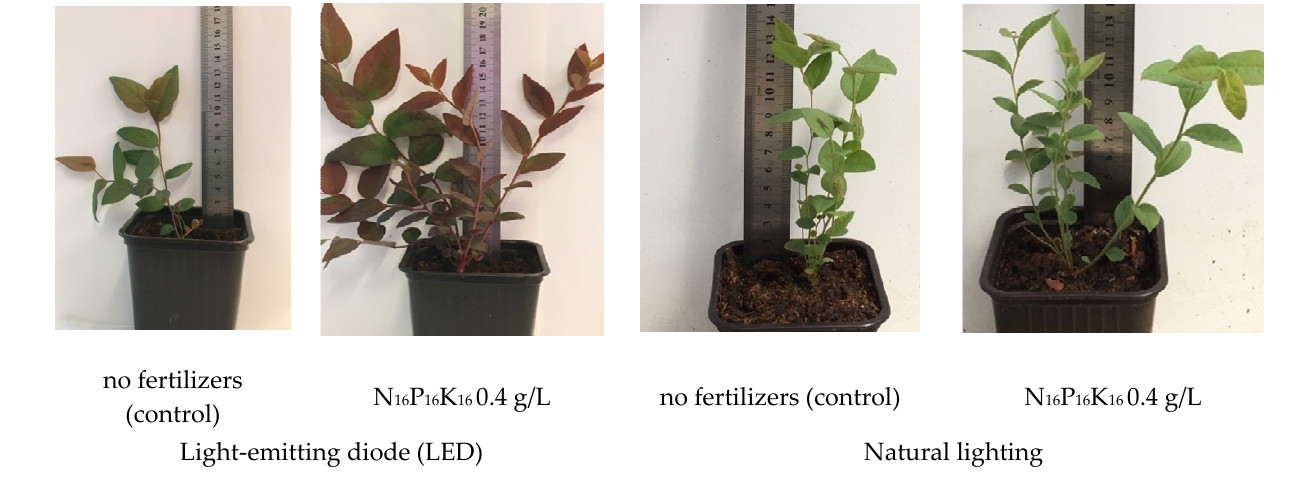
Figure 3. External appearance of ex vitro highbush blueberry ( Vaccinium corymbosum L.) plants on the 56th day of growing completion.